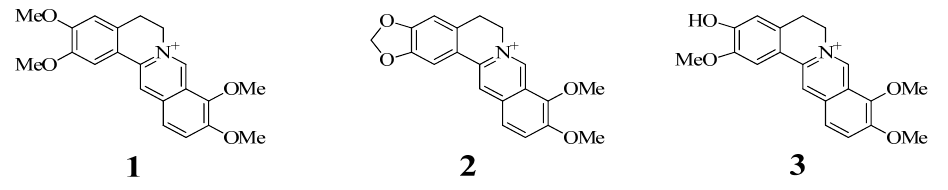
Table 1. sEH inhibitory effect of quaternary isoquinoline alkaloids 1 – 3